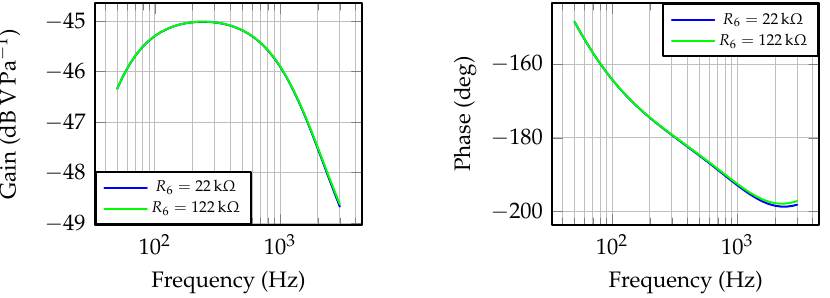
Figure 9. Frequency response of the CMA-4544PF-W electret condenser microphone with pre- amplifying stage built-in around the low-noise OA